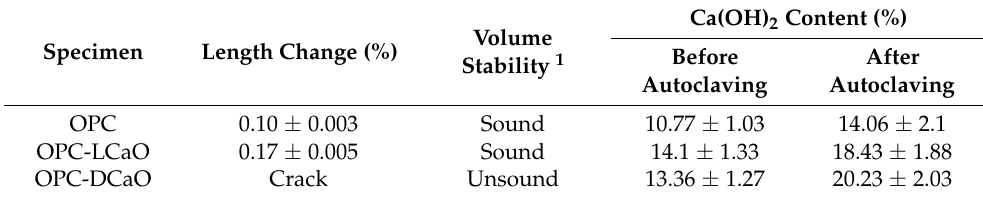
Table 4. Ca(OH) 2 content (%) before and after autoclaving related to volume stability with different types of calcination CaO.